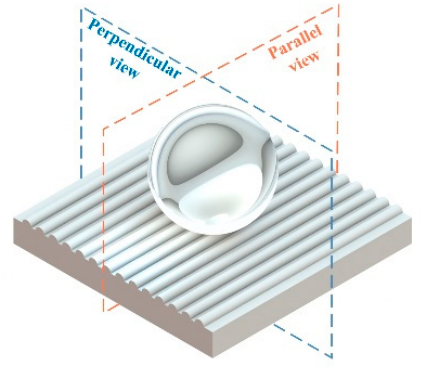
Figure 9. Schematic diagram of measurement direction.